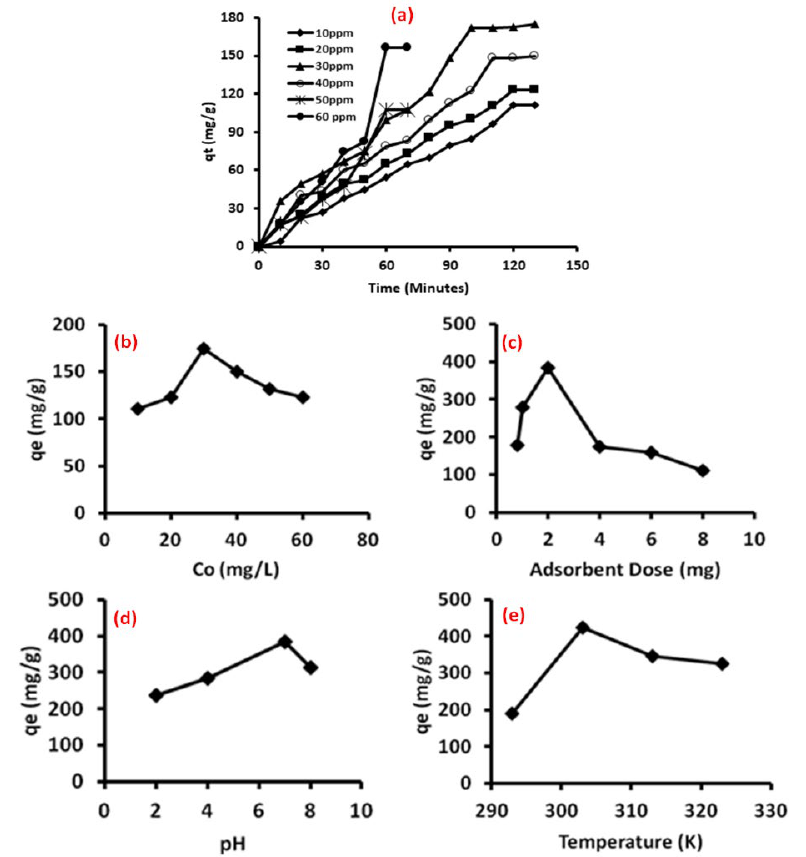
Figure 6. Effect of various parameters on adsorption capacity at equilibrium ( a ) Time, ( b ) concentration of dye, ( c ) adsorbent dose, ( d ) pH and ( e ) temperature.